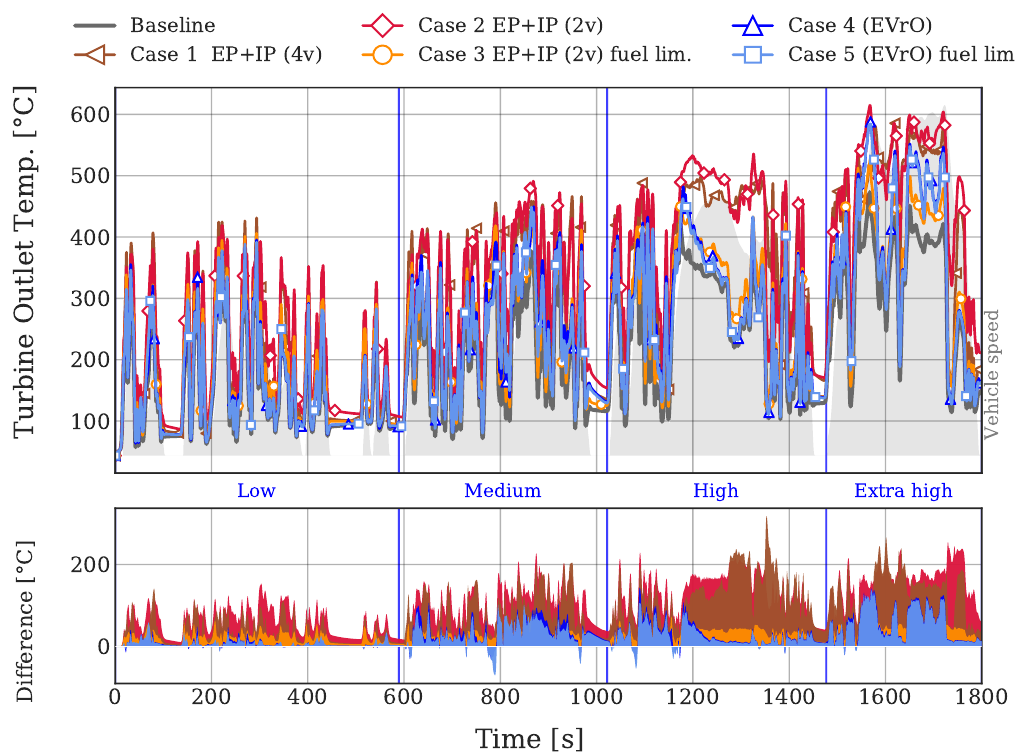
Figure 9. Worldwide Harmonized Light-Duty Vehicles Test Cycle (WLTC) temperature at turbine